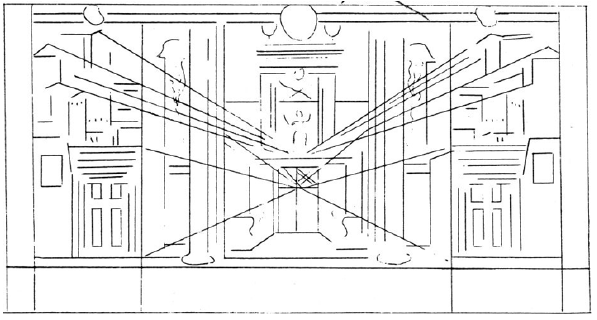
Figure 22. So-called vanishing vertical axis, as applied by Little (1971, plate III, Figure 2).